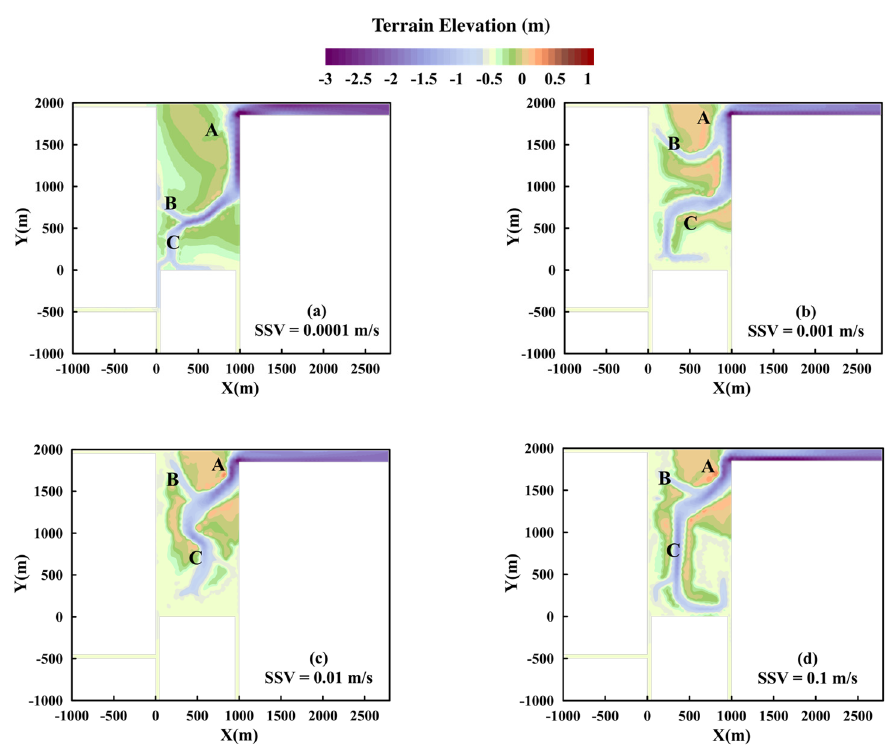
Figure 10. Terrain patterns of the ideal model of Qilihai Lagoon system under different SSVs, after 100 years, where the SSV is ( a ) 0.0001 m/s, ( b ) 0.001 m/s, ( c ) 0.01 m/s and ( d ) 0.1 m/s. Erosion amount (EA), deposition amount (DA), and net erosion amount (NEA) per unit area for different SSV, after 100 years, are shown in Table 3. Similar to the CDSS, the increase of SSV intensified the deposition, but the EA and the DA decreased, due to the aforementioned mutual restriction of erosion and deposition. When the SSV varied from 0.0001 m/s to 0.001 m/s, the NEA decreased by 10.8 kg/m 2 ; however, with a further in- crease of the SSV to 0.1 m/s, the NEA only declined by 5.8 kg/m 2 . This implies that low SSV has a greater influence on geomorphological evolution. Table 3. Erosion amount (EA), deposition amount (DA), and net erosion amount (NEA) per unit area for different SSVs, after 100 years. Dependent Variables